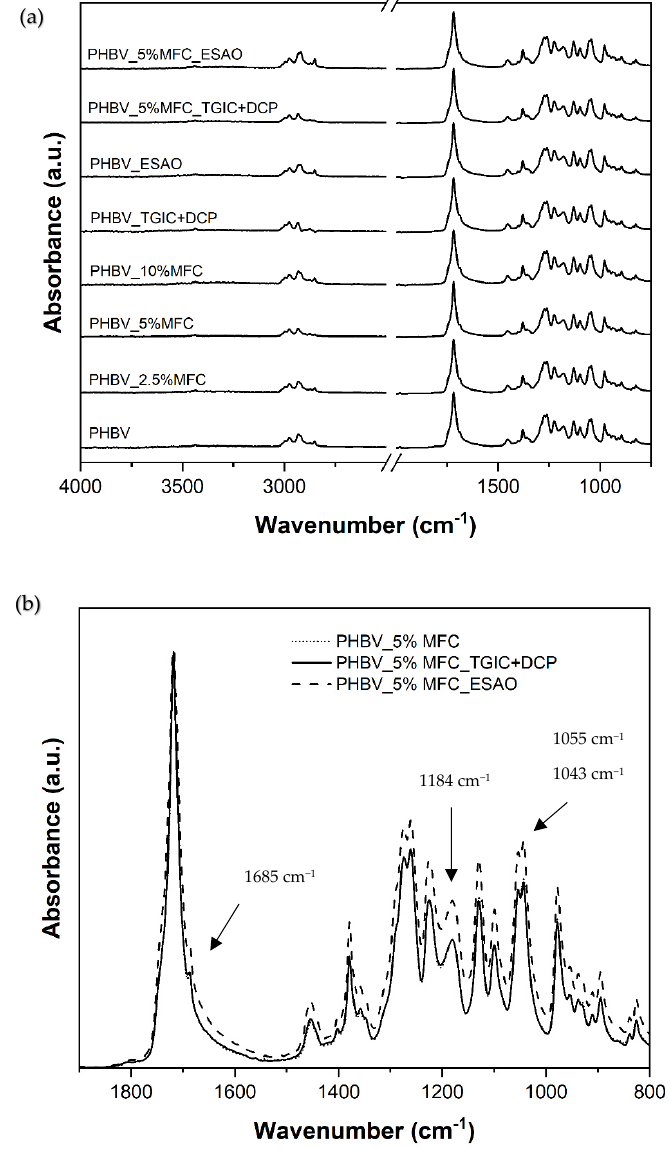
Figure 5. ( a ) Fourier transform infrared (FTIR) spectra, from bottom to top, of the films of the following: poly(3-hydroxybutyrate- co -3-hydroxyvalerate) (PHBV), PHBV with microfibrillated cellulose (MFC) at 2.5, 5, and 10 wt%, PHBV with triglycidyl isocyanurate (TGIC) and dicumyl peroxide (DCP) and with epoxy-based styrene-acrylic oligomer (ESAO), and PHBV/MFC at 5 wt% with TGIC and DCP and with ESAO. ( b ) Detail of the FTIR spectra for the films of PHBV/MFC at 5 wt% uncompatibilized and compatibilized with TGIC and DCP and with ESAO. Arrows indicate the wavenumbers of the chemical bonds described in the